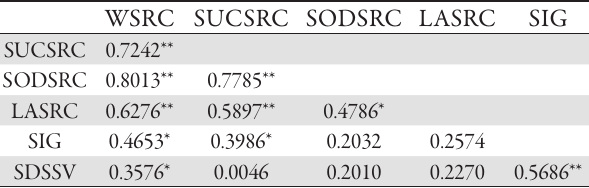
Tab. 4. Correlation among SIG, SDS, SRCs of wholemeal flour WSRC SUCSRC SODSRC LASRC